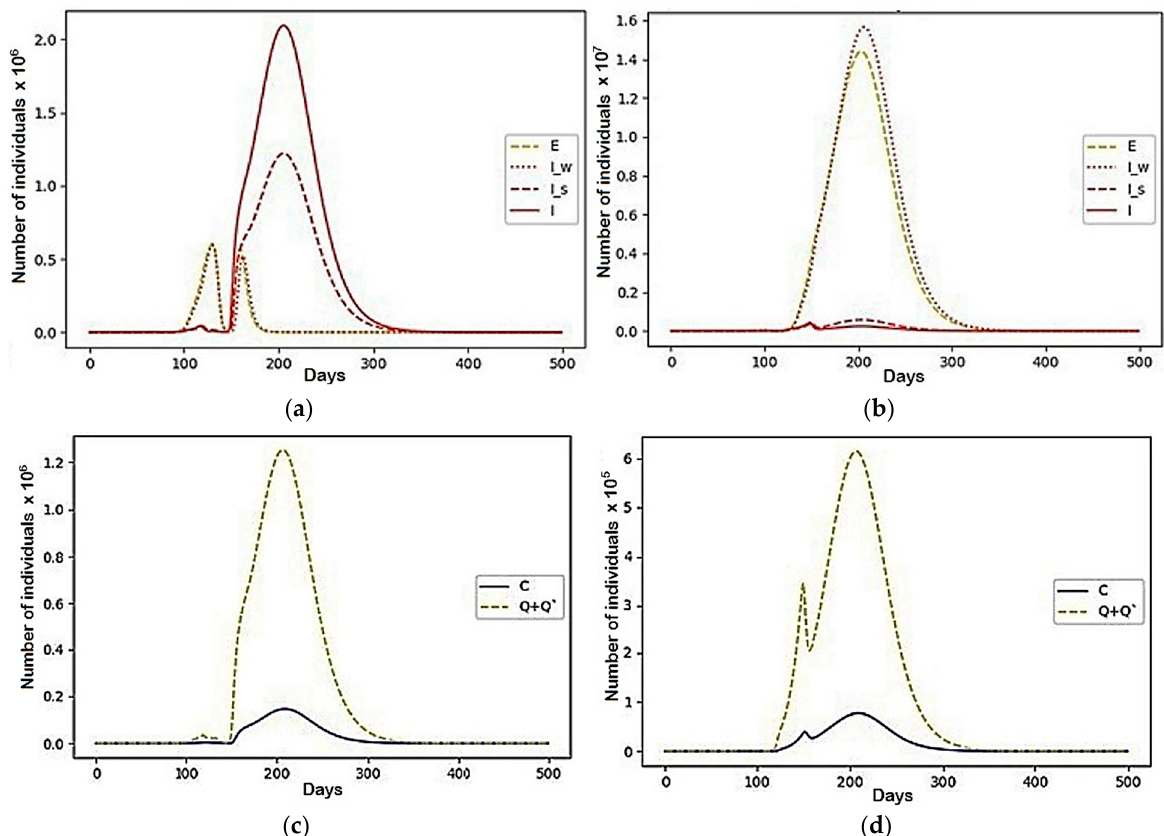
Figure 13. A scenario with the parameters represented in Table 2: ( a ) Region 3; ( b ) Region 4.